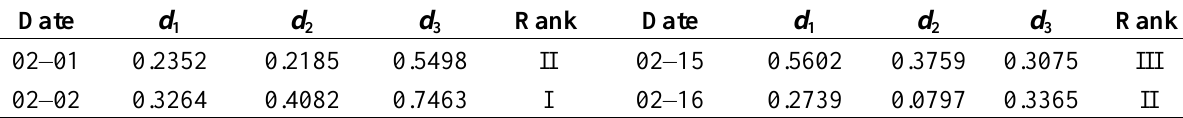
Table 6. Evaluation results based on Ambient Air Quality Standards (GB